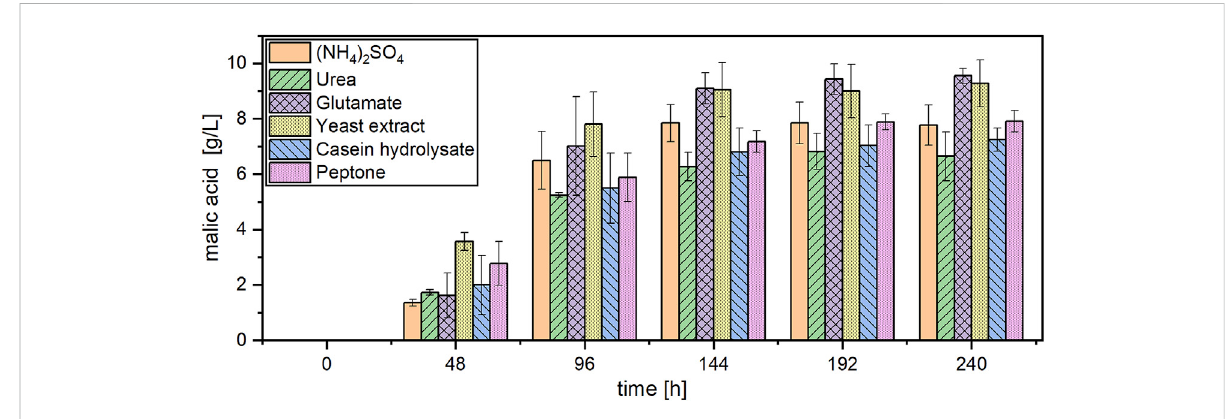
FIGURE 3 Malic acid production with A. oryzae using different nitrogen sources. Datapoints represent means ± standard deviation, n = 3.